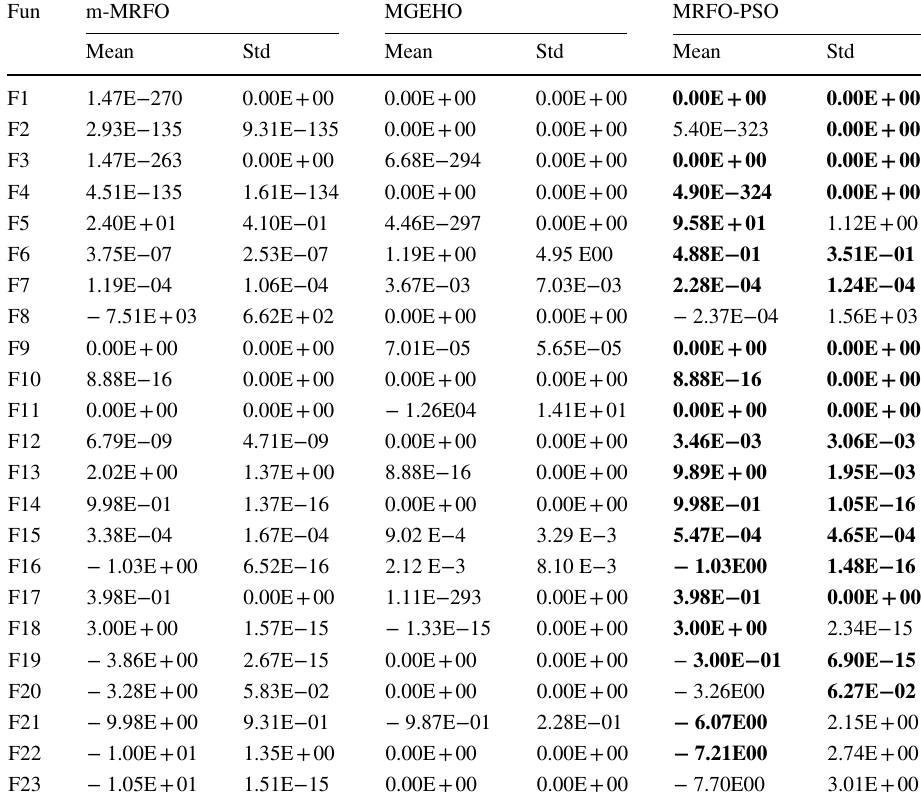
Table 5 The comparison of the MRFO-PSO and some advanced variants of MRFO